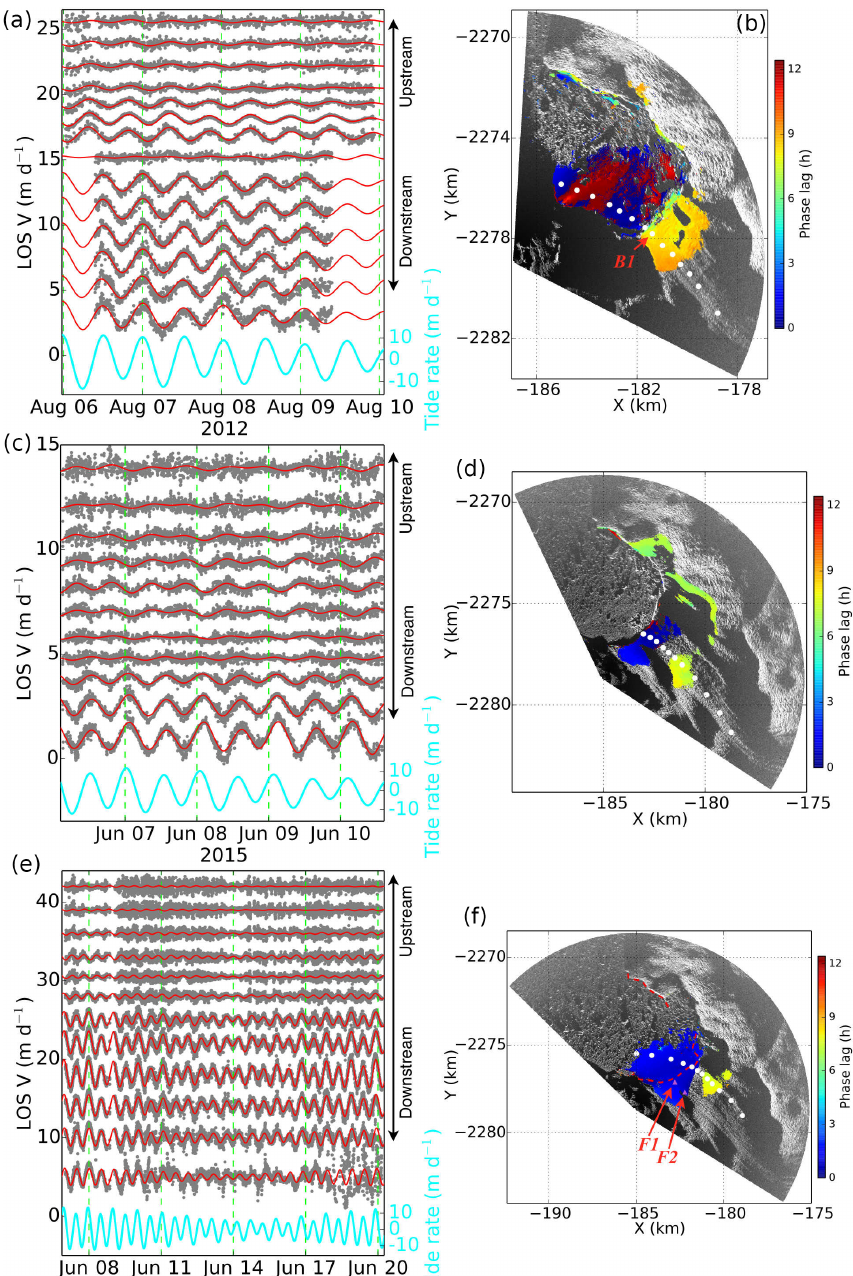
Figure 4. Phase lag map and velocity time series for a profile in each campaign. Grey dots (a, c, e) show detrended LOS velocity time series for a profile along the ice flow line, marked by white dots on the map to the right. Red curve shows best model fit. LOS velocities are offset for clarity. Cyan curve shows tidal rate. Phase lag map (b, d, f) shows M2 frequency signal. Areas where SNR < 1.5 are omitted. Phase lags are converted to times (in hours). In (f) , dashed red line shows TRI-derived location of glacier front on 13 June 2016. B1, F1, and F2 mark selected points showing velocity time series in Fig. 6. Note that the amplitude of detrended LOS velocity depends on a number of factors, including tidal response, ice flow direction relative to radar LOS, distance up-glacier, whether the scanned area is glacier or mélange, and (within the mélange) whether the imaged pixel is close to or far from the calving